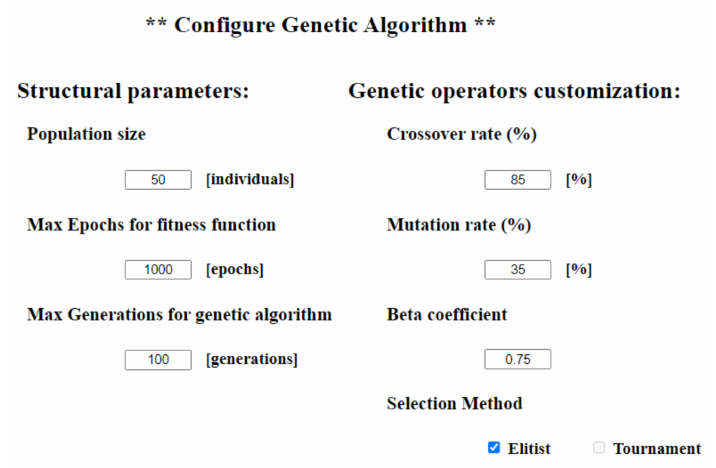
Figure A2. Genetic algorithm configuration page.